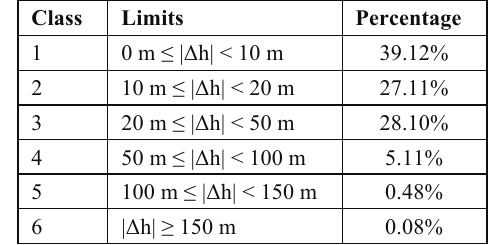
Table 2. Classes of elevation differences between Switzerland and Piedmont and their percentages.